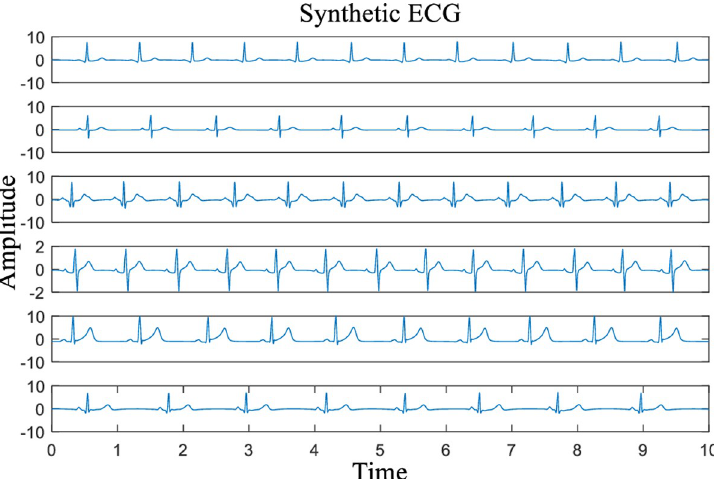
Fig 5. Synthetic ECG signals with a sampling rate of 360 Hz in 10 s (from top to bottom, the names of the signals are Syn00, Syn01, Syn02, Syn03, Syn04 and Syn05).